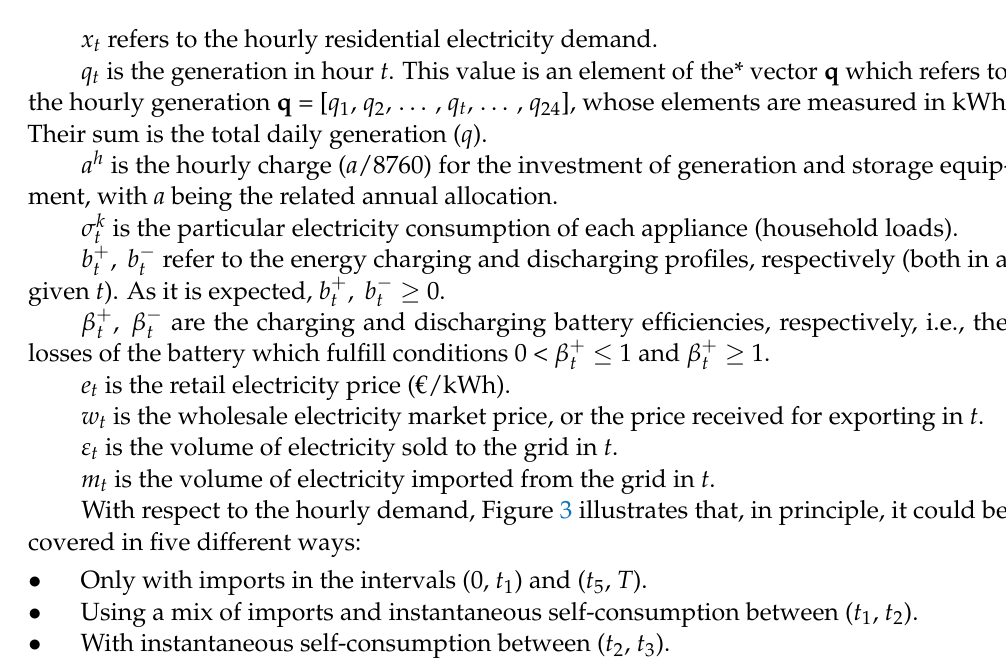
Figure 3. Load and generation profiles. Source: Own